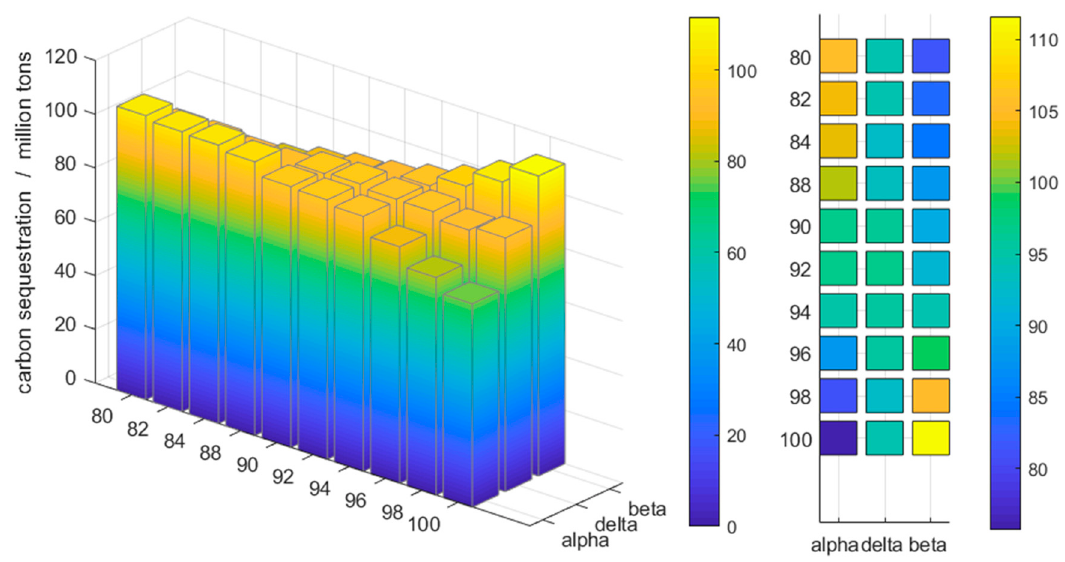
Figure 8. Sensitivity analysis for changing three important